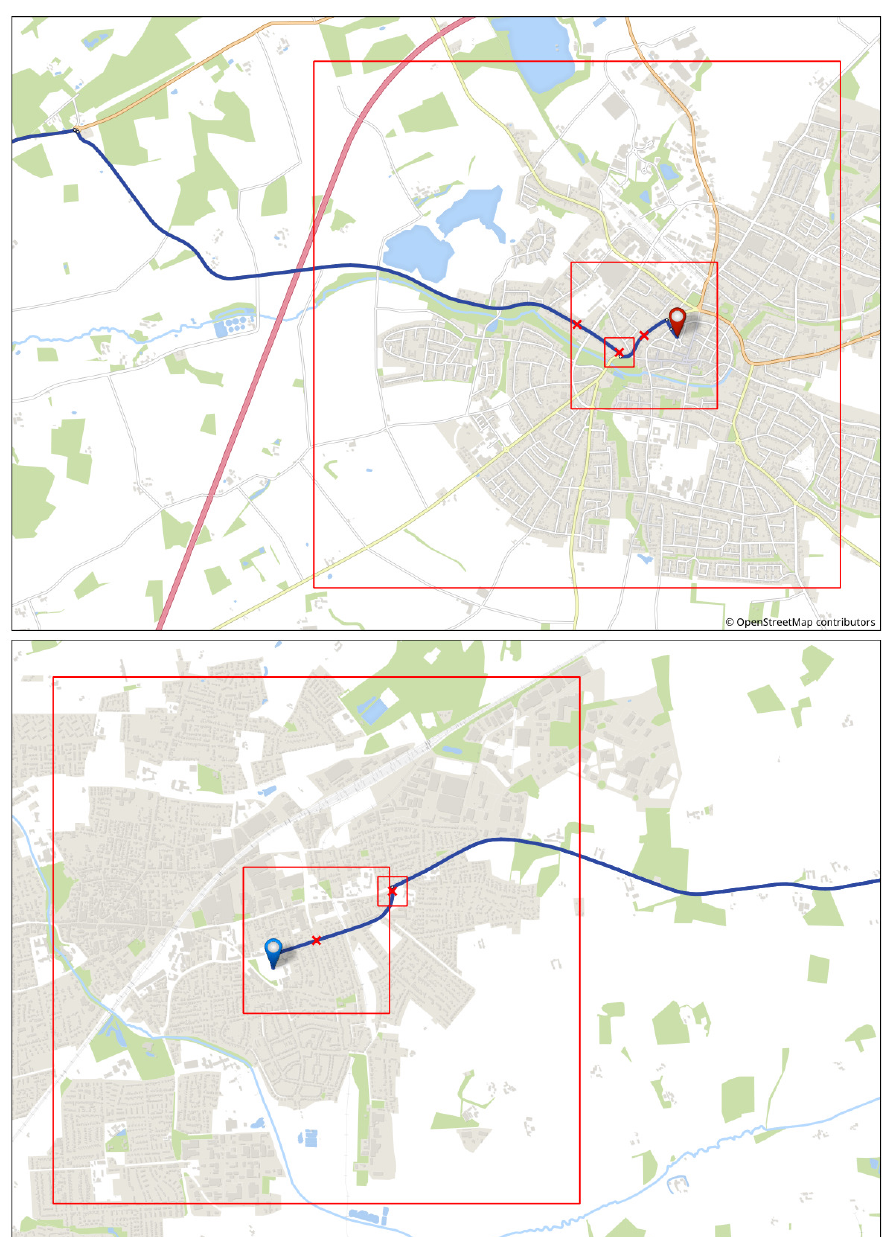
Figure 2: Selection of location (red marks) and target scales (red frames) for the selection and refinement of orientation information; top: case 1; bottom: case